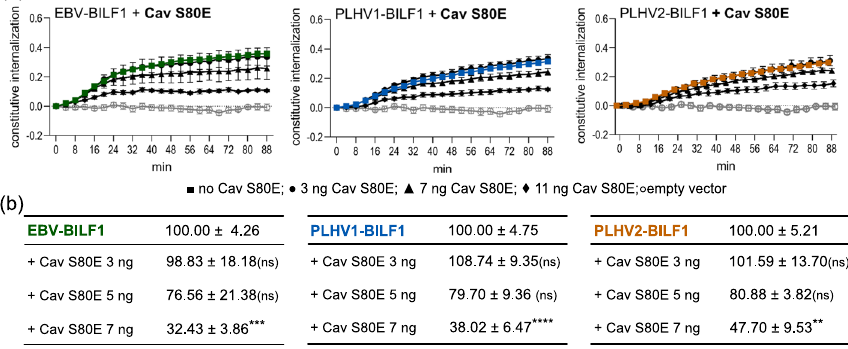
Table 2 Interaction (S/N ratio) of BILF1 receptors with caveolin-1 determined using the informational spectrum method (ISM) Protein